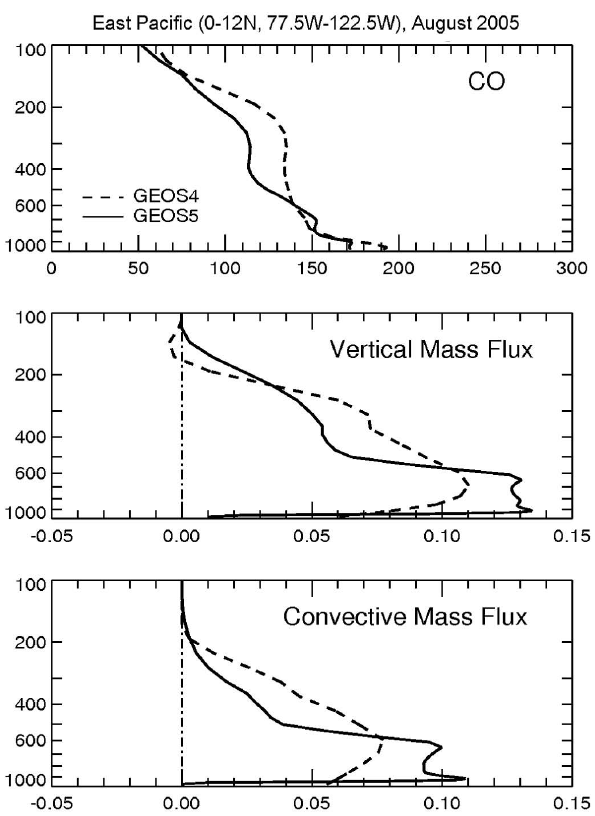
Fig. 16. Vertical profiles of CO (top), total vertical mass flux (mid- dle), and convective mass flux (bottom) in August 2005 over the East Pacific (0 ◦ –12 ◦ N, 77.5 ◦ W–122.5 ◦ W) for simulations driven by GEOS-4 (dashed) and GEOS-5 (solid). Mass flux is in Pas − 1 , CO is in ppb.